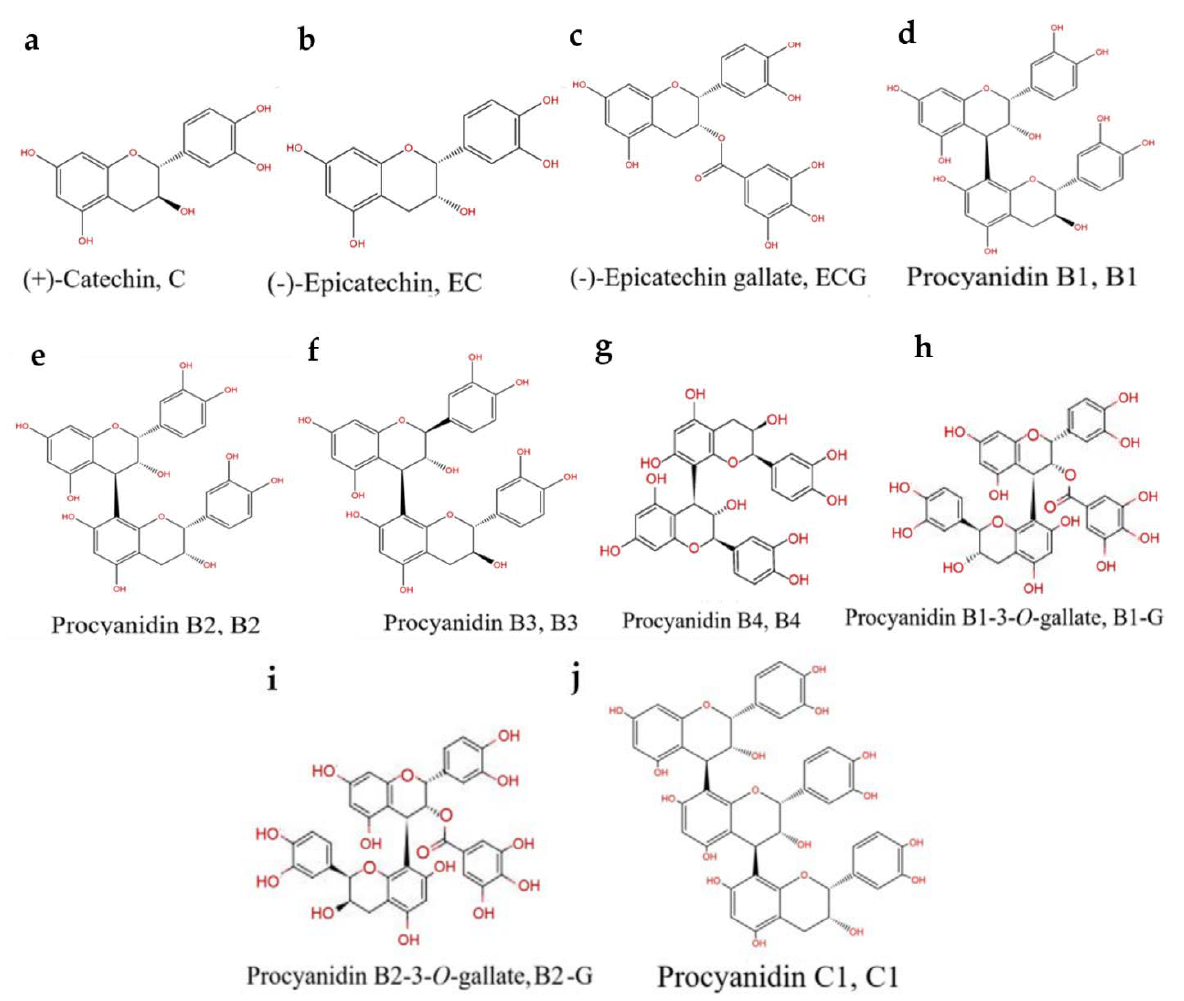
Figure 1. PCs structure: ( a ) (+)-Catechin (C). ( b ) (-)-Epicatechin (EC). ( c ) (-)-Epicatechin gallate (ECG). ( d ) Procyanidin B1 (B1). ( e ) Procyanidin B2 (B2). ( f ) Procyanidin B3 (B3). ( g ) Procyanidin B4 (B4). ( h ) Procyanidin B1-3- O -gallate (B1-G). ( i ) Procyanidin B2-3-O-gallate (B2-G). ( j ) Procyanidin C1 (C1).